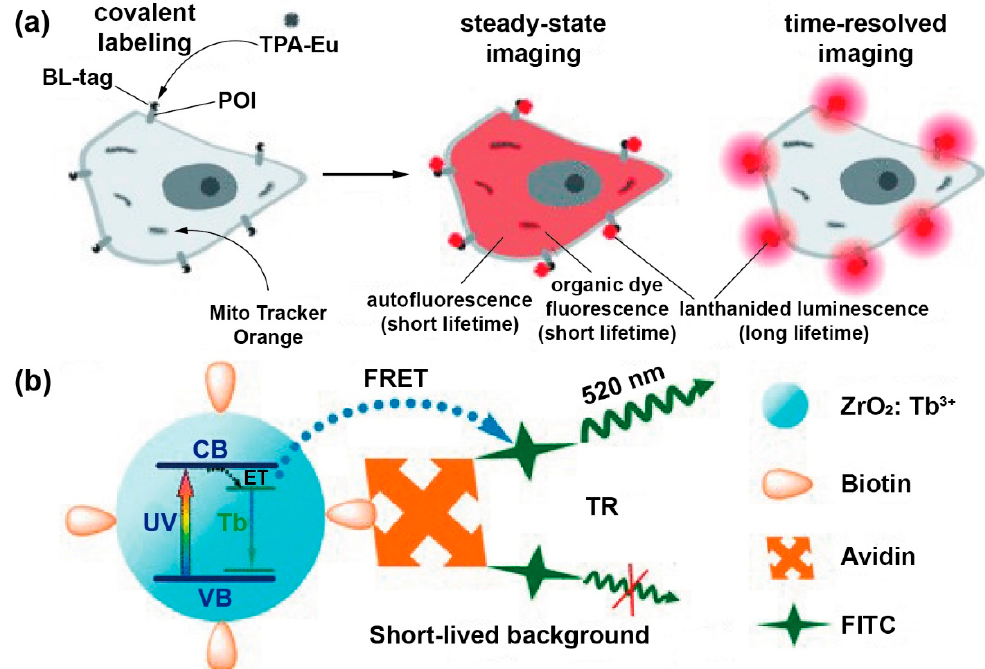
Figure 9. ( a ) Schematic representation of mutant β -lactamase-based protein labeling system, in which the luminescent lanthanide probe (TPA-Eu) was used for imaging cell-surface proteins (POIs). Reproduced with permission from [77]. Copyright 2011, WILEY-VCH. ( b ) Schematic diagram of TR-FRET detecting of avidin by employing biotinylated NCs (donor) and FITC (acceptor). Reproduced with permission from [79]. Copyright 2011, WILEY-VCH.